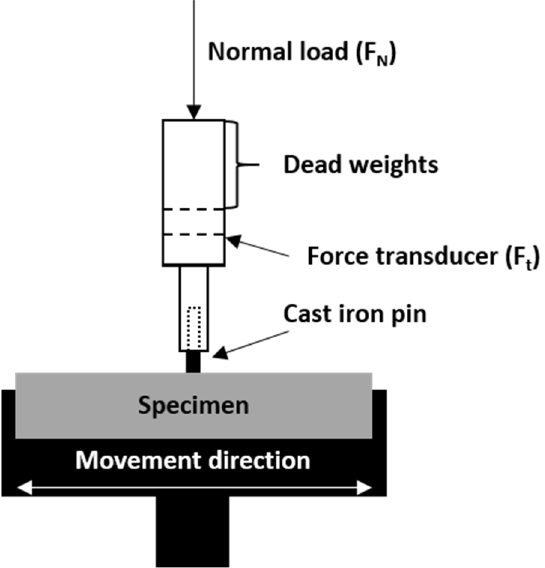
Figure 3. Schematic diagram of the pin-on-block TM-01M tribometer used in the tests. The velocity of 0.1 m/s was applied using a cast iron counter sample ( ϕ = 3 mm) over